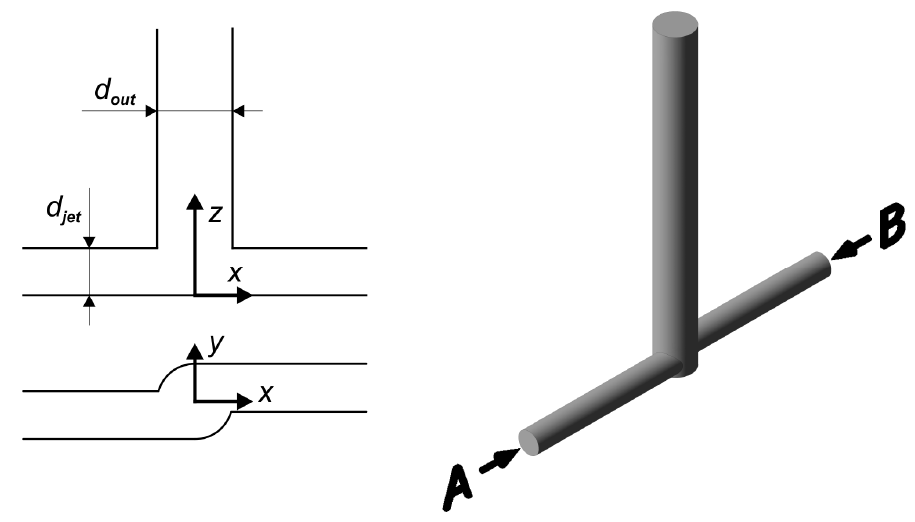
Figure 2. Geometry of a vortex T-mixer (V-mixer).